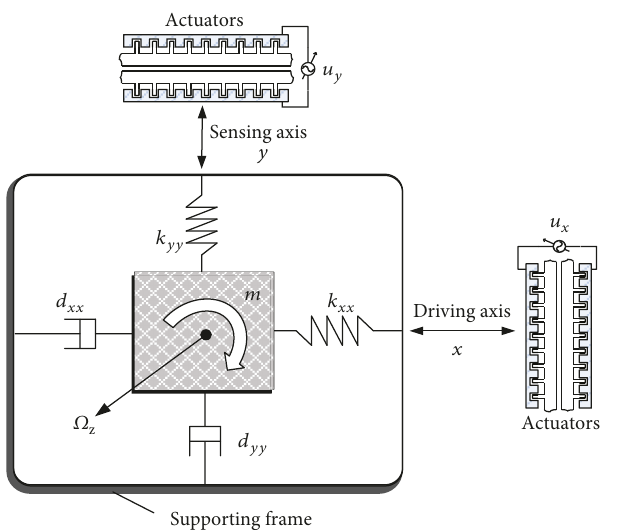
Figure 1: Schematic diagram of a z -axis